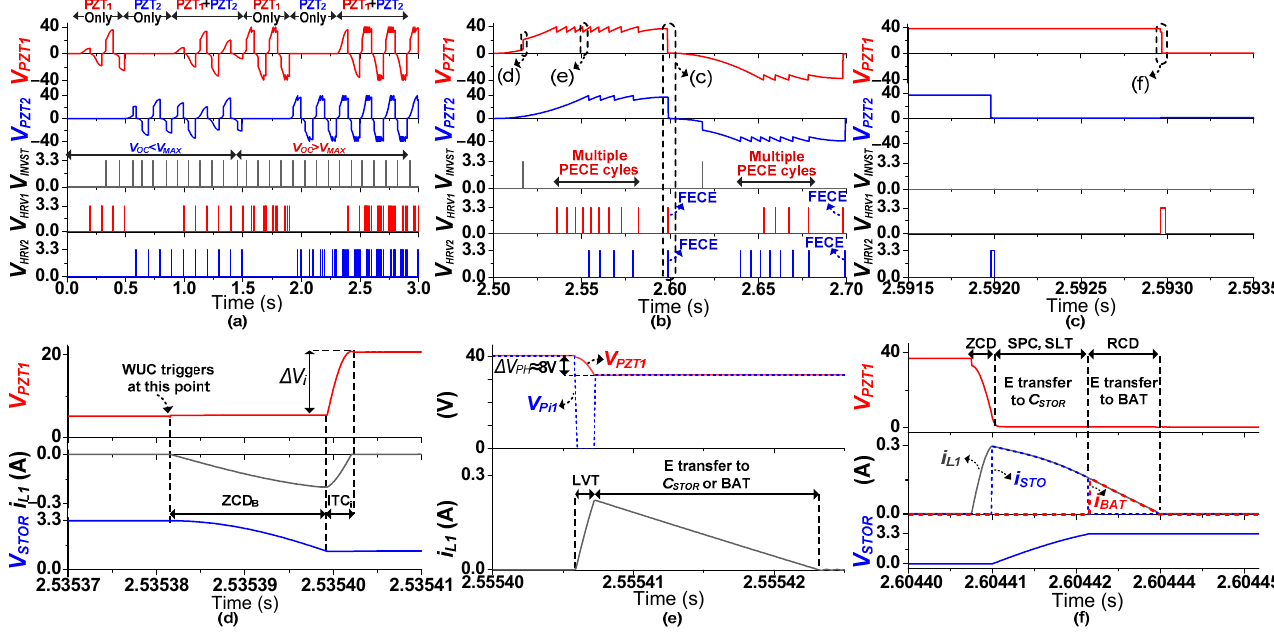
Figure 10. Simulation results of dual-PZT energy-harvesting circuit. ( a ) Random input excitations applied to both PZTs separately and simultaneously. ( b ) Zoomed output voltages of both PZTs increasing simultaneously. ( c ) Harvesting signal sequences after peak detection. ( d ) An energy-investment cycle of PZT 1 . ( e ) A PECE cycle of PZT 1 . ( f ) An FECE cycle after peak detection.